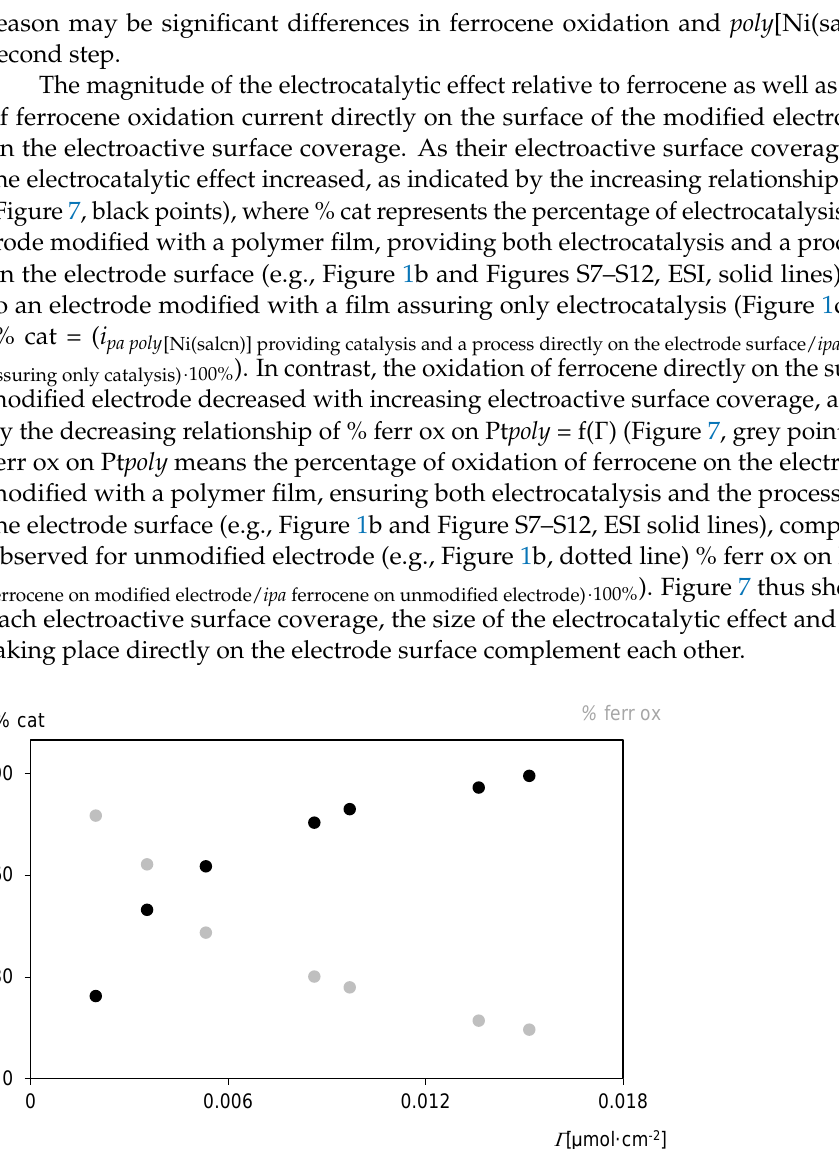
Figure 7. Plots of % catalysis (black points) and % oxidation of ferrocene at Pt poly [Ni(salcn)] (% ferr ox) (grey points) vs. electroactive surface coverage ( Γ ). Data from Figures 1 and